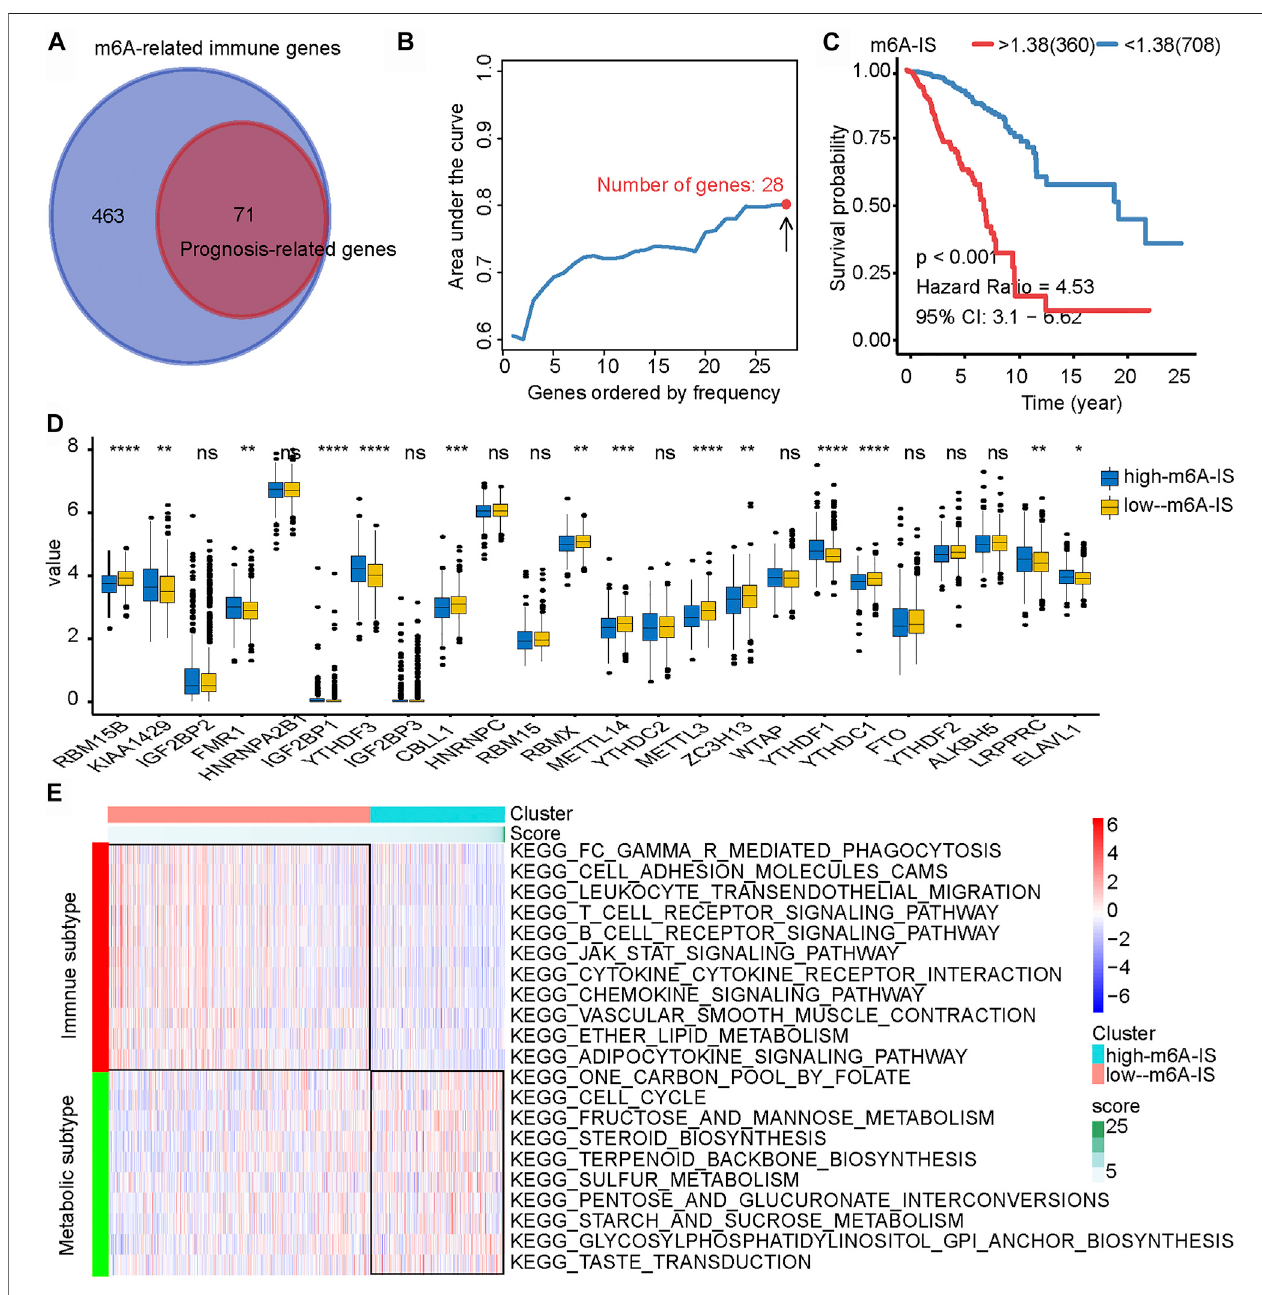
FIGURE 3 | Construction of the N 6 -methyladenosine-related immune score (m6A-IS) and analysis of its characteristics. (A) Through correlation analysis, a total of 534 tumor microenvironment (TME)-related genes were found to be signi fi cantly positively or negatively correlated with m6A regulators (|Pearson ’ s correlation coef fi cient| ≥ 0.5and p < 0.001; Figure2A ).Then,univariateCoxregressionanalysisfurtherrevealedthat71TME-relatedimmunegenesweresigni fi cantlyrelatedtothe prognosis of breast cancer ( p < 0.05; Figure2A ). (B) The iterative LASSO algorithm was used to analyze a total of 71 TME-related genes. (C) The low m6A-IS subgroup showed longer survival than the high-m6A-IS subgroup (HR (cid:1) 4.53, 95% CI (cid:1) 3.04 – 6.66, p < 0.001). (D) Expressions of the 24 m6A regulators between the high- and low-m6A-IS groups ofpatientswith breast cancer. High score, blue ; low score, yellow . The boxbounds representan interquartile range of values, center lines representthemedianvalue,and blackdots showoutliers. Asterisks representthestatistical p -value(* p < 0.05;** p < 0.01;*** p < 0.001). (E) Heatmapofthesigni fi cantly enriched terms in the Kyoto Encyclopedia of Genes and Genomes (KEGG) pathways.